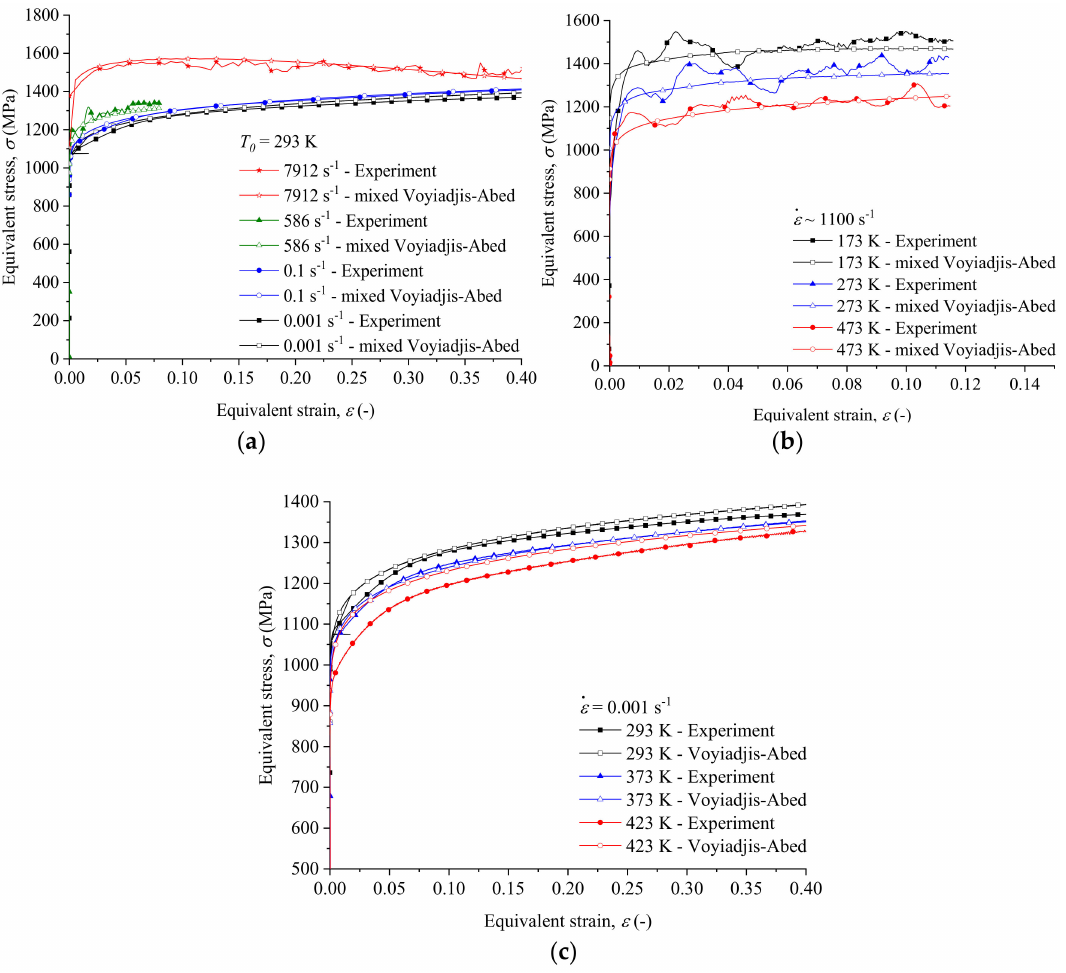
Figure 15. Comparison of the mixed Voyiadjis–Abed model and the experimental data: ( a ) for different strain rates, at T 0 =293 K; ( b ) for different temperatures, at ˙ ε ~1100 s − 1 and ( c ) for different temperatures, at ˙ ε = 0.001 s − 1